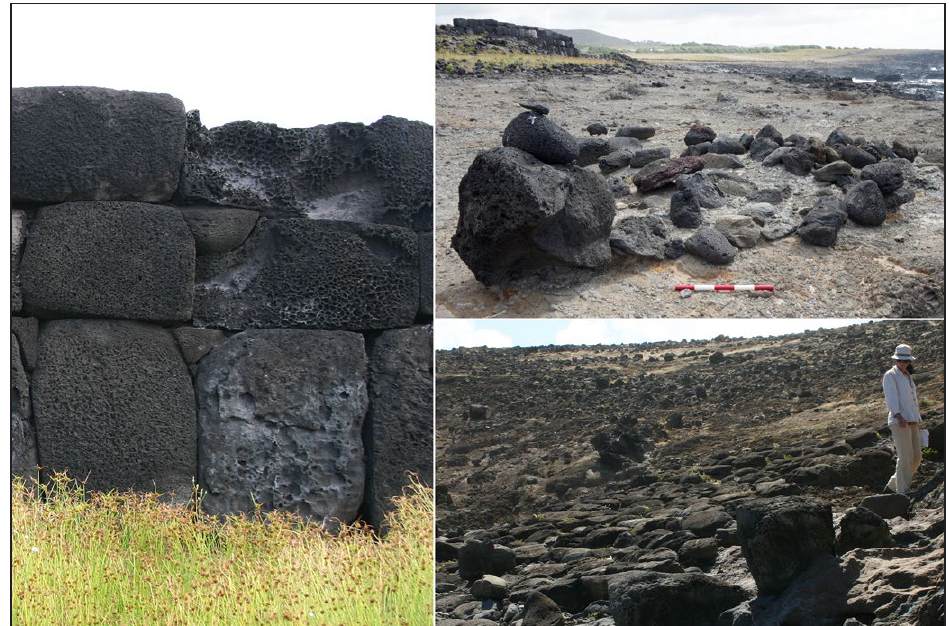
Figure 2: Coastal ahu are open to many threats. Left: tafoni in the rear wall of Ahu Ha ŋ a Poukura caused by the re-crystallization of absorbed salt within the rock. Top right: also to the rear of Ahu Ha ŋ a Poukura, the remains of a sea-washed crematorium. Bottom right: a paved route to a freshwater spring at the shore’s edge at Ahu Ha ŋ a Tete ŋ a, which is being degraded by wave action and by people and animals accessing the spring. Photos: Sue Hamilton (left) & Mike Seager Thomas